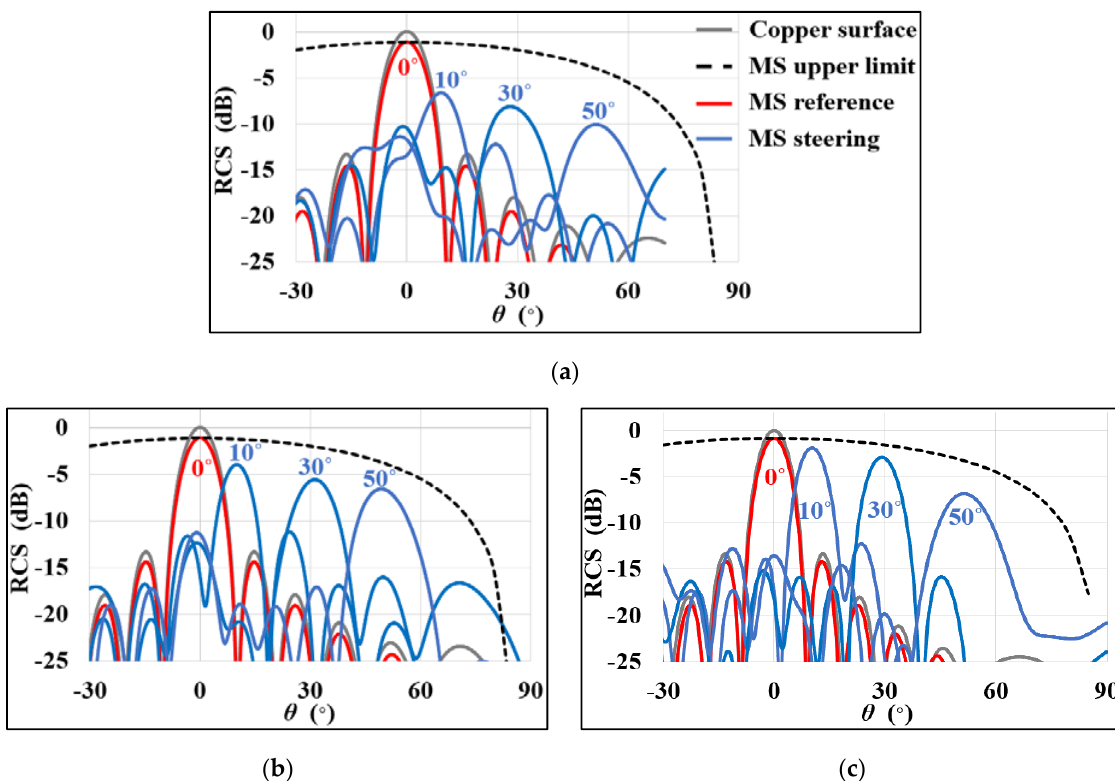
Figure 15. Far ‐ field simulation results for MS reflector: ( a ) at 11 GHz, ( b ) at 12 GHz, and ( c ) at 13.5 GHz.